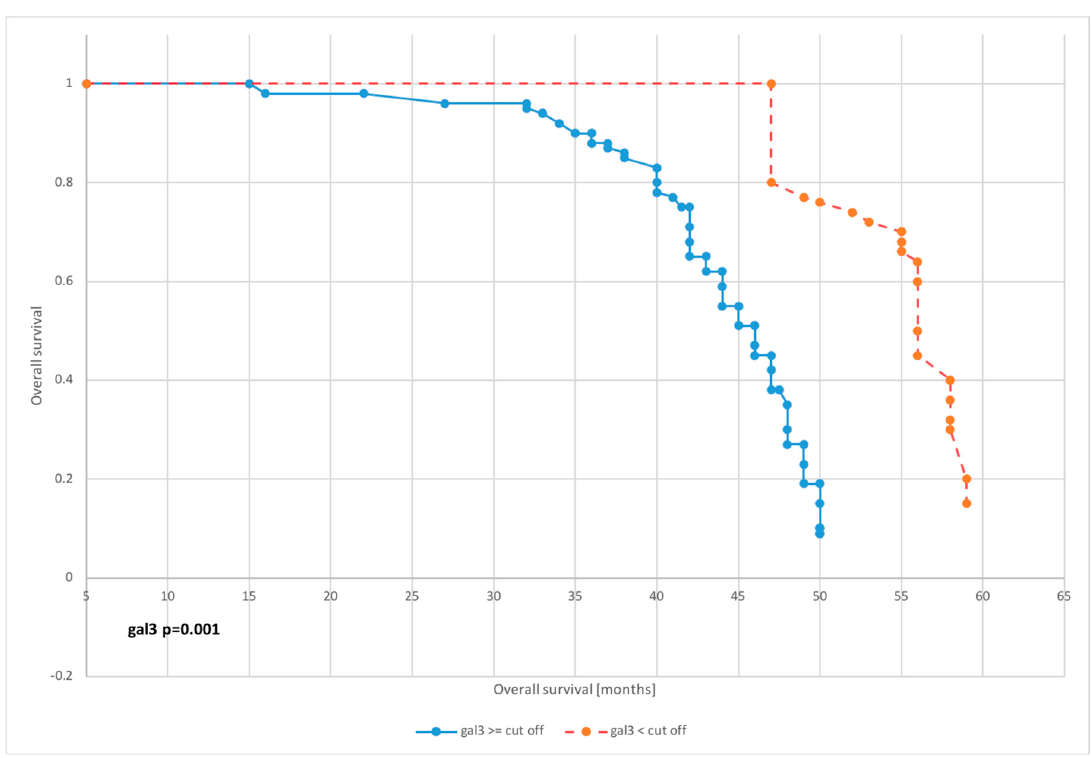
Figure 5. Kaplan–Meier overall-free survival curves for endometrial cancer patients based on serum galectin 3 level for cutoff. Diagnostics 2020 , 10 , x FOR PEER REVIEW